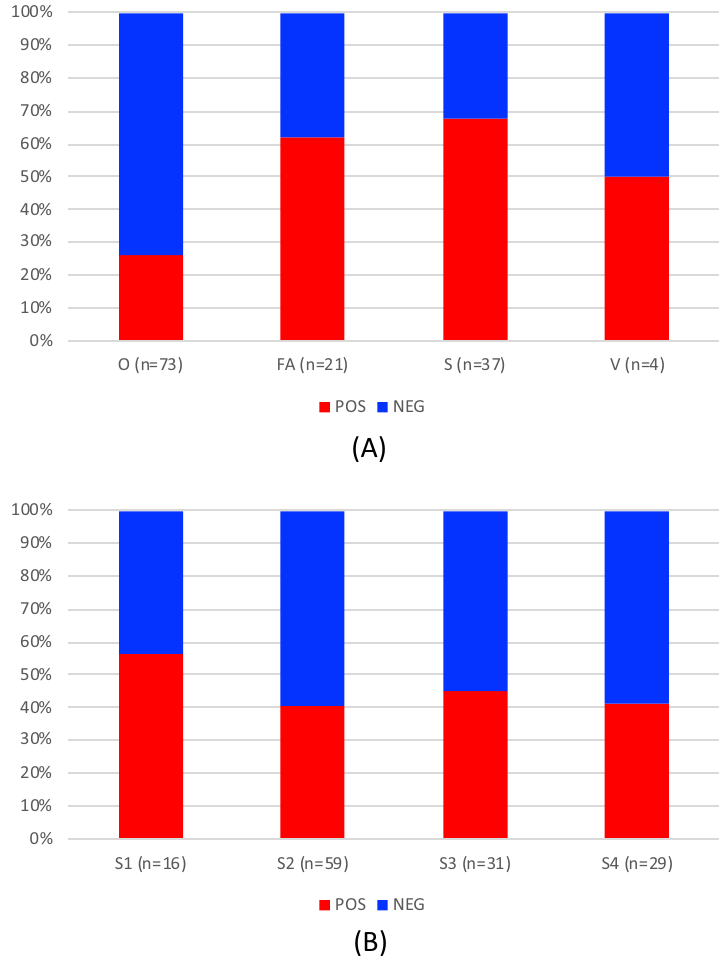
Figure 2. Incidence of positive responses (Monk Seal DNA detection in at least one sample replicate) across sample types ( A ) and geographic sectors ( B ). In the top graph, O = Opportunistic, FA = Focus Area, S = Surveillance , V = Validation samples. In the bottom graph S1 = Balearic Islands; S2 = Corsica, Sardinia and Tuscany archipelago, S3 = Sicily, S4 = Ionian and Adriatic